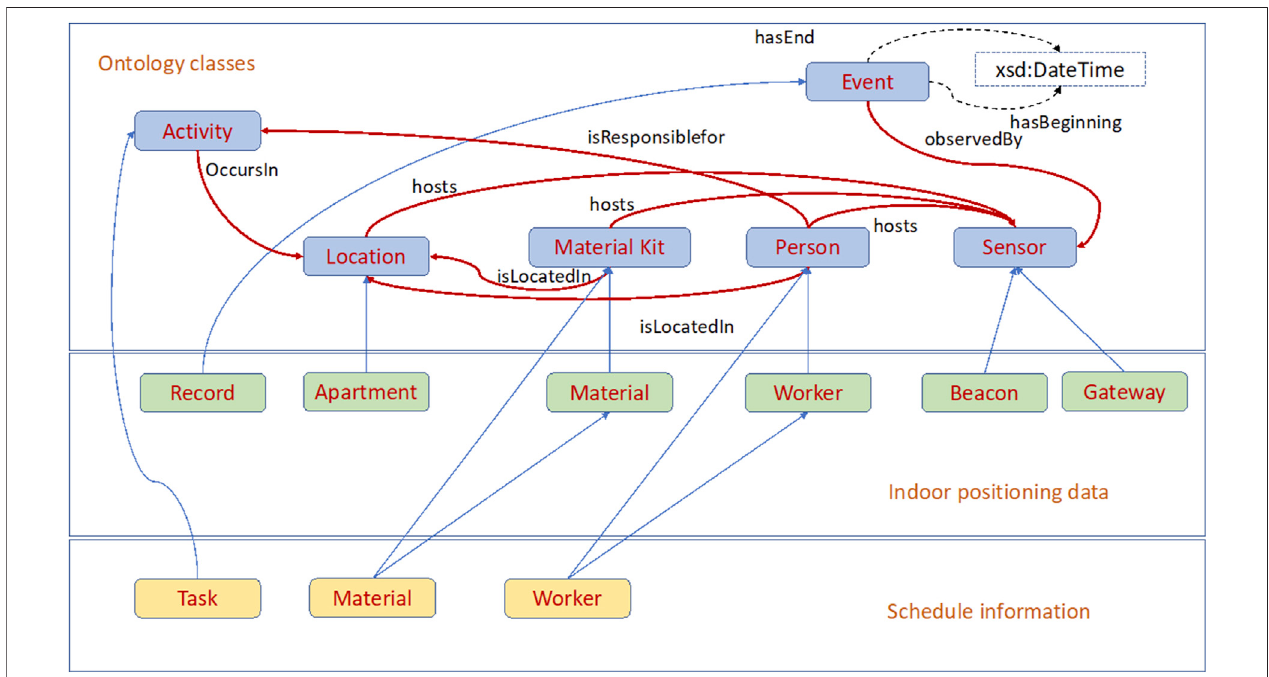
FIGURE 6 | Mapping the indoor position data to